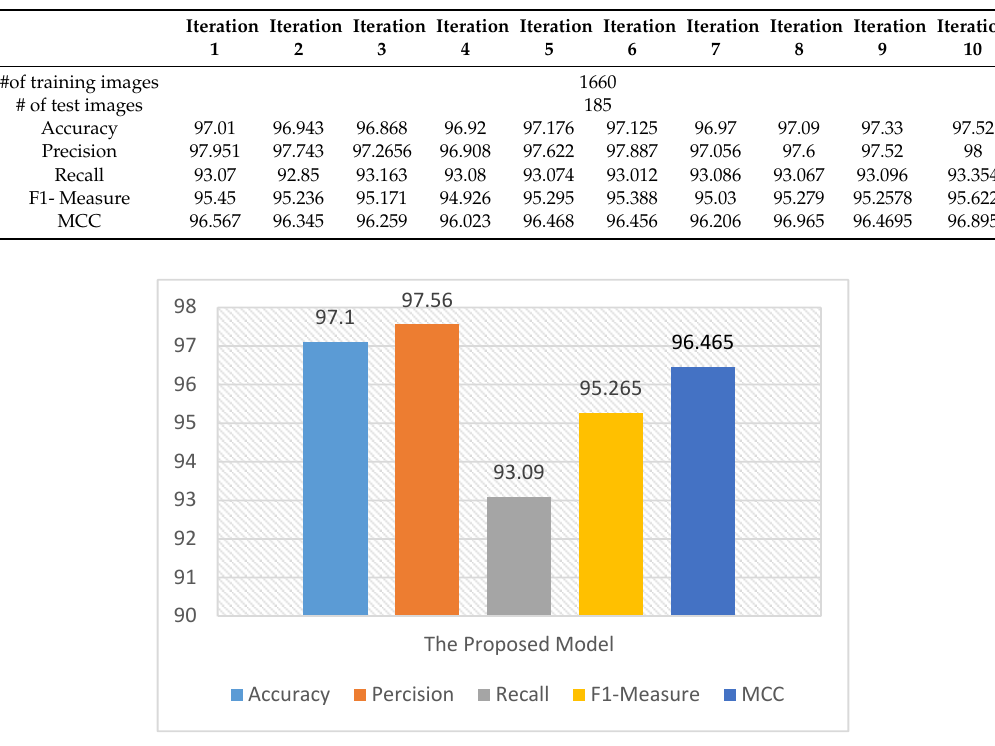
Figure 11. The 10-fold cross-validation average result on DVMM using the proposed model. Table 6. The detailed results of 10-fold cross-validation on the NIST 17 dataset using the proposed model.